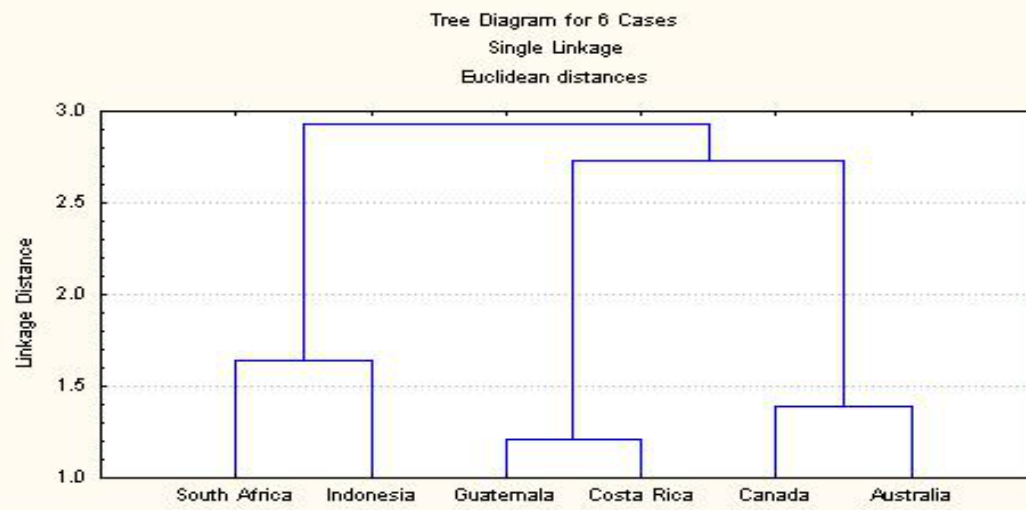
Figure 3: Cluster analysis – countries’ economic status